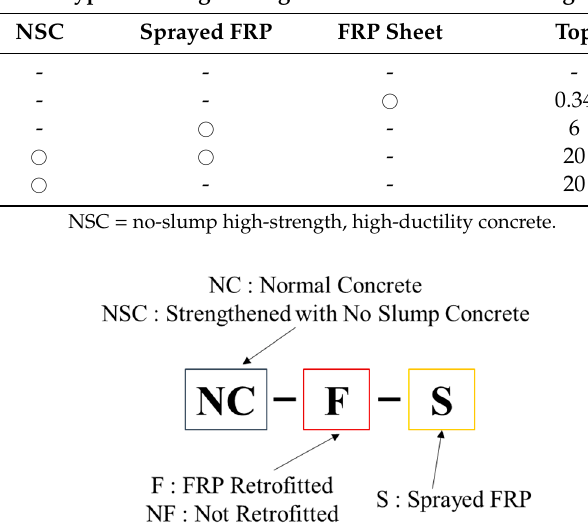
Figure 2. Designation of the test specimens.